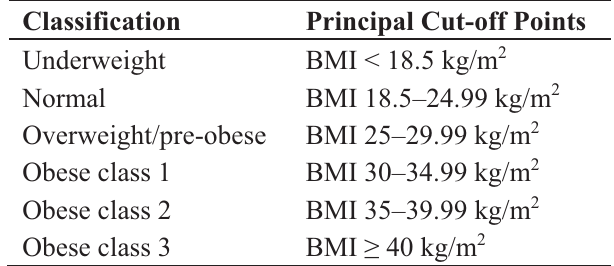
Table 1. The international classification of adult underweight, overweight and obesity according to Body Mass Index (BMI) adapted from the World Health Organization (WHO)